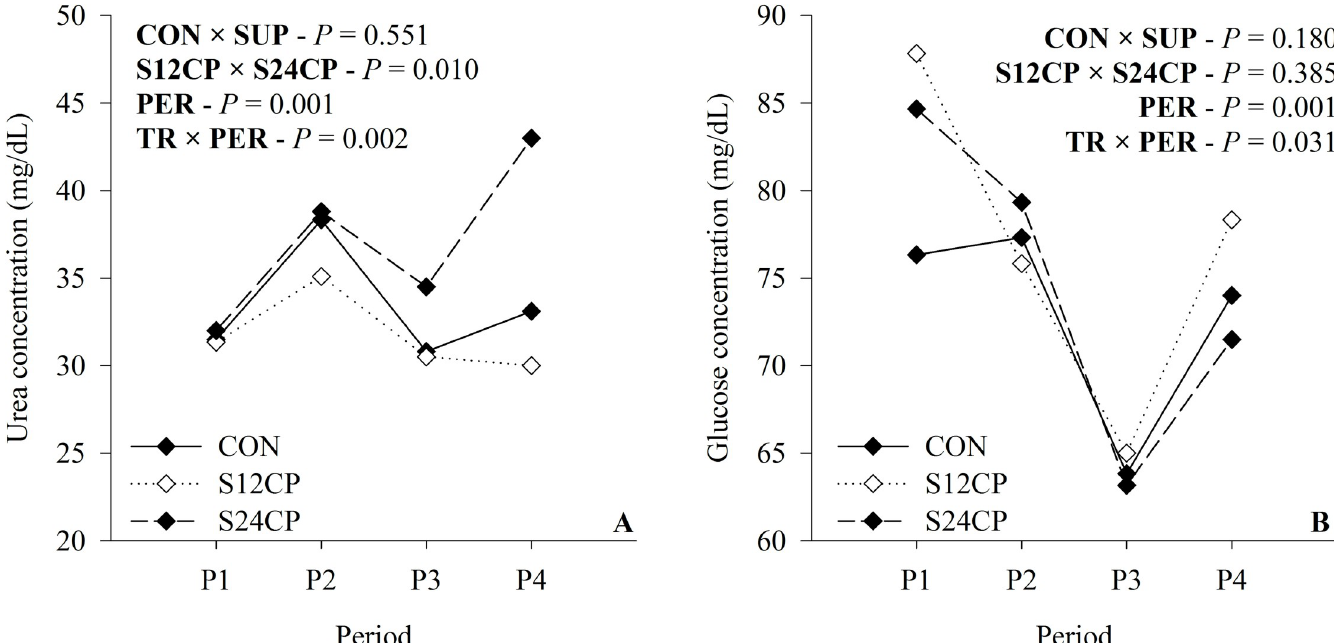
Fig 3. Blood urea (A) and glucose (B) concentration of Holstein x Gyr crossbred heifers on a rotational grazing system Panicum maximum cv. Mombac¸a pasture. � CON = not supplemented; S12CP: supplemented with concentrate containing 12% CP; S24CP: supplemented with concentrate containing 24% CP. � CON × SUP = effect of supplementation; S12CPB × S24CP = effect of supplement protein levels; PER = effect of period; TR × PER = interaction effect between supplementation and period. https://doi.org/10.1371/journal.pone.0239786.g003 S12CP ( P = 0.011; Table 6). The CON had a high blastocysts per cleaved oocytes when com- pared with SUP ( P = 0.019; Table 6). In addition, S24CP presented a tendency to greater blas- tocysts per cleaved oocytes when compared with S12CP ( P = 0.055; Table 6). The blastocysts per cleaved oocytes averages were 58.30%, 15.26%, and 44.57% for CON, S12CP, and S24CP,